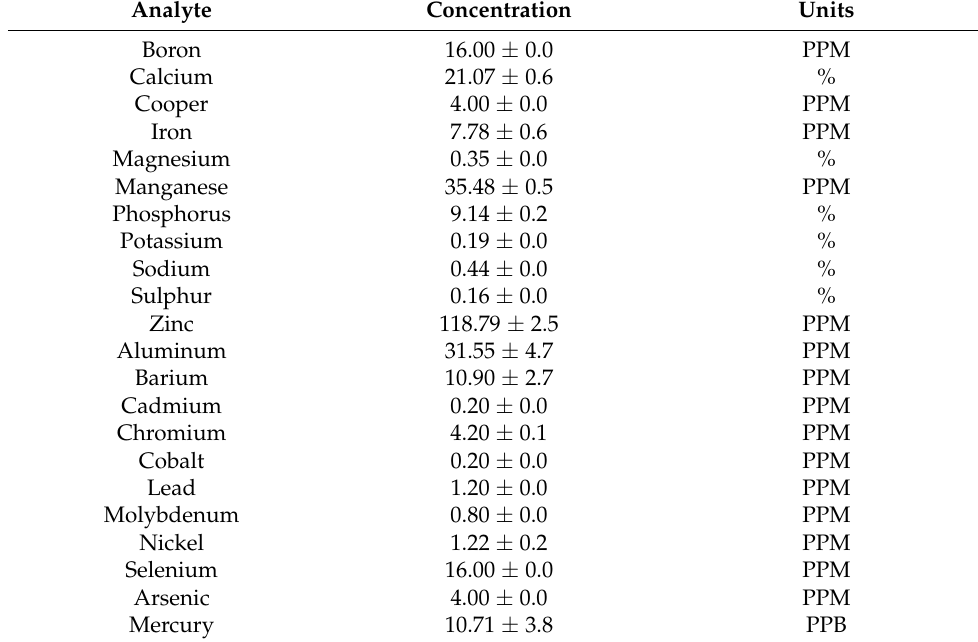
Table 1. Mineral and metal composition ˆ of catfish bone powder (dry wt basis). Analyte Concentration